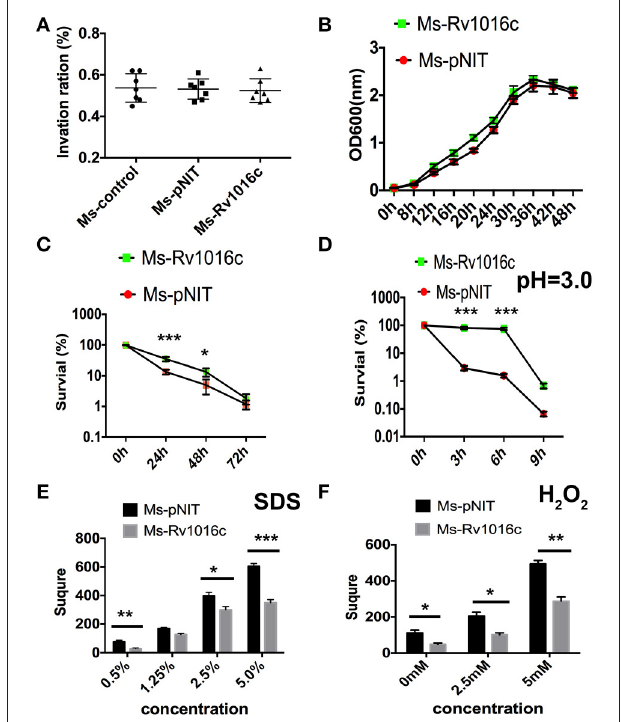
FIGURE 2 | Rv1016c promotes intracellular survival of M. smegmatis and boost the recombinants resistance to stress factors within macrophages. (A) THP-1 cells were infected with Ms_pNIT or Ms_Rv1016c at an MOI of 10 at day 0 (4h post-infection). Invasion ratio is the ratio of the number of intracellular bacteria and the number of initial infection bacteria. (B) Growth of Ms_Rv1195 and Ms_pNIT strains at 37 ◦ C in 7H9 liquid medium were assayed by OD600 value in every 4 h. (C) THP-1 cells were infected with Ms _pNIT or Ms_Rv1016c at the MOI of 10. After infection, Lysates containing the live bacteria were diluted gradually and then plated on 7H10 agar plates to determine bacteria number. (D) Growth of Ms _pNIT or Ms_Rv1016c under Low pH (pH = 3) was measured in vitro . The bacteria were collected by centrifugation and resuspended to an OD600 of 0.8 in 20 ml 7H9. The cultures were incubated at 37 ◦ C and 0.1 ml removed for viable count enumeration. (E,F) Growth of Ms _pNIT or Ms_Rv1016c under stress conditions. Disk diffusion method was used to measure the survival of recombinant Ms_Rv1016c when exposure to SDS (E) and H2O2 (F) . All results were generated from three independent experiments and Data are shown as Means ± SD of triplicate wells. (* p < 0.05, ** p < 0.01, *** p < 0.001, determined